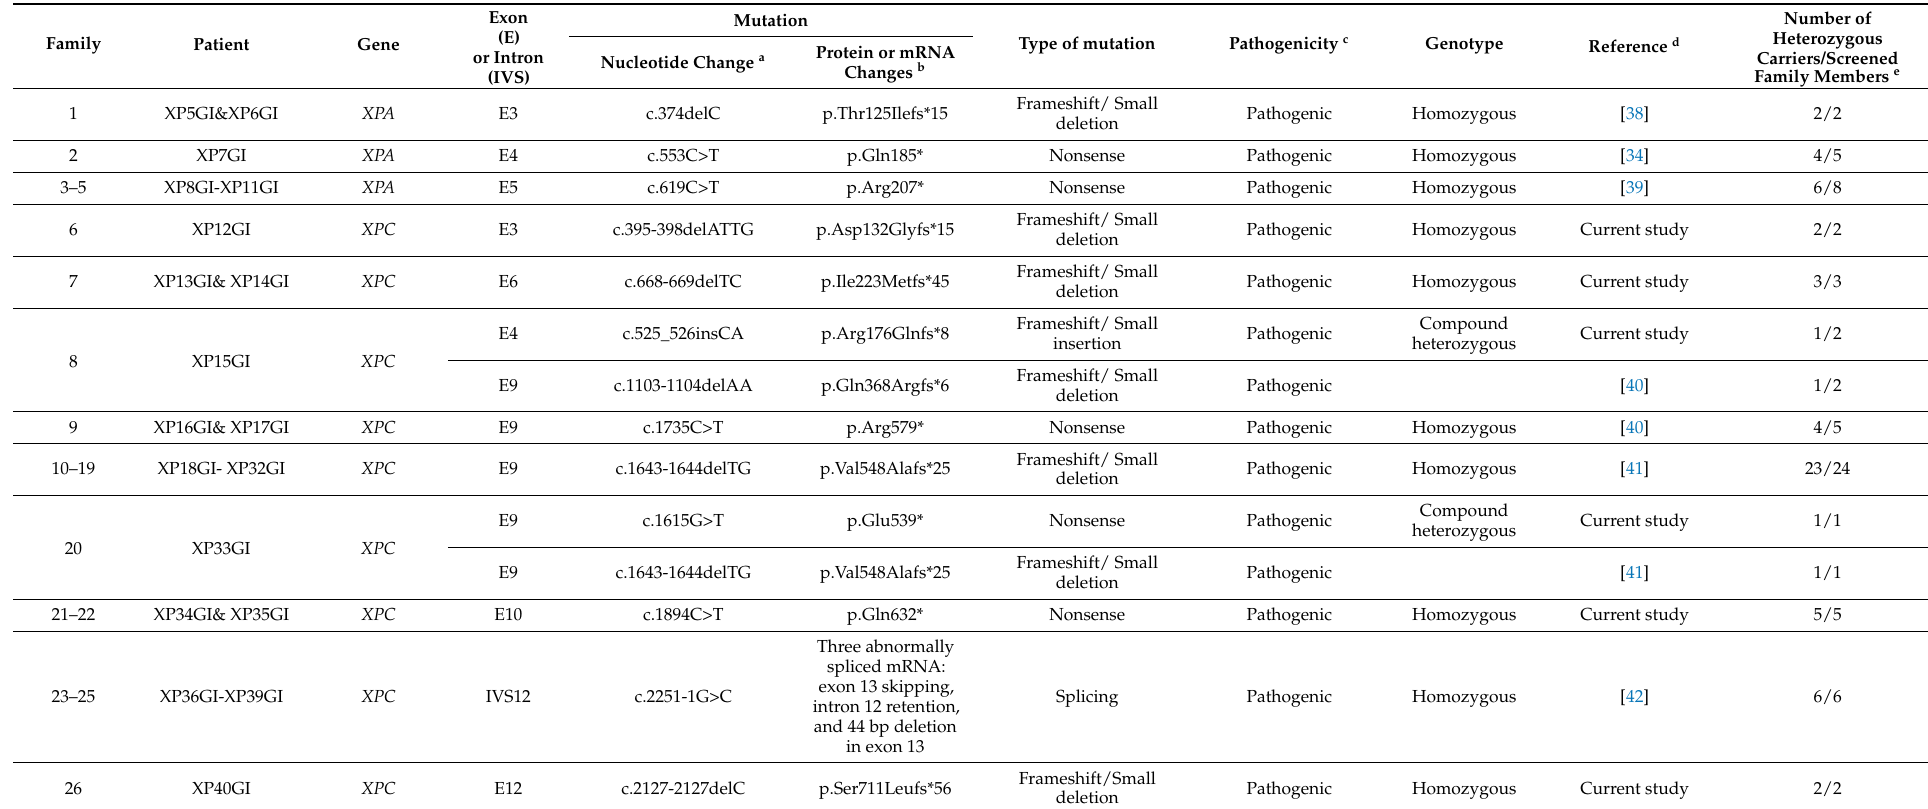
Table 3. XPA and XPC mutations in 36 Egyptian xeroderma pigmentosum XP